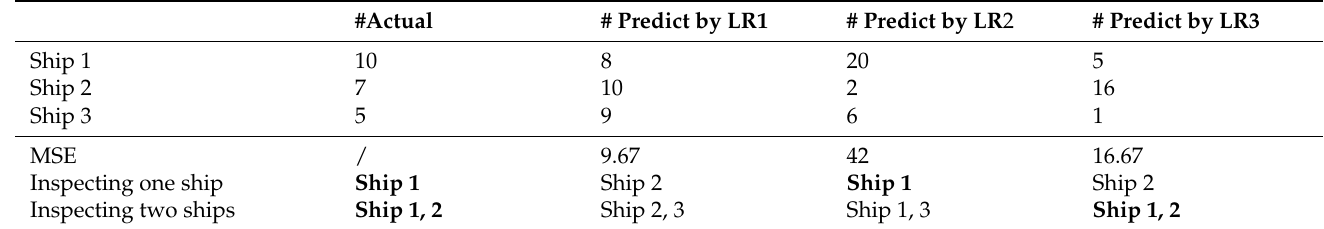
Table 3. A counter example in the ship selection